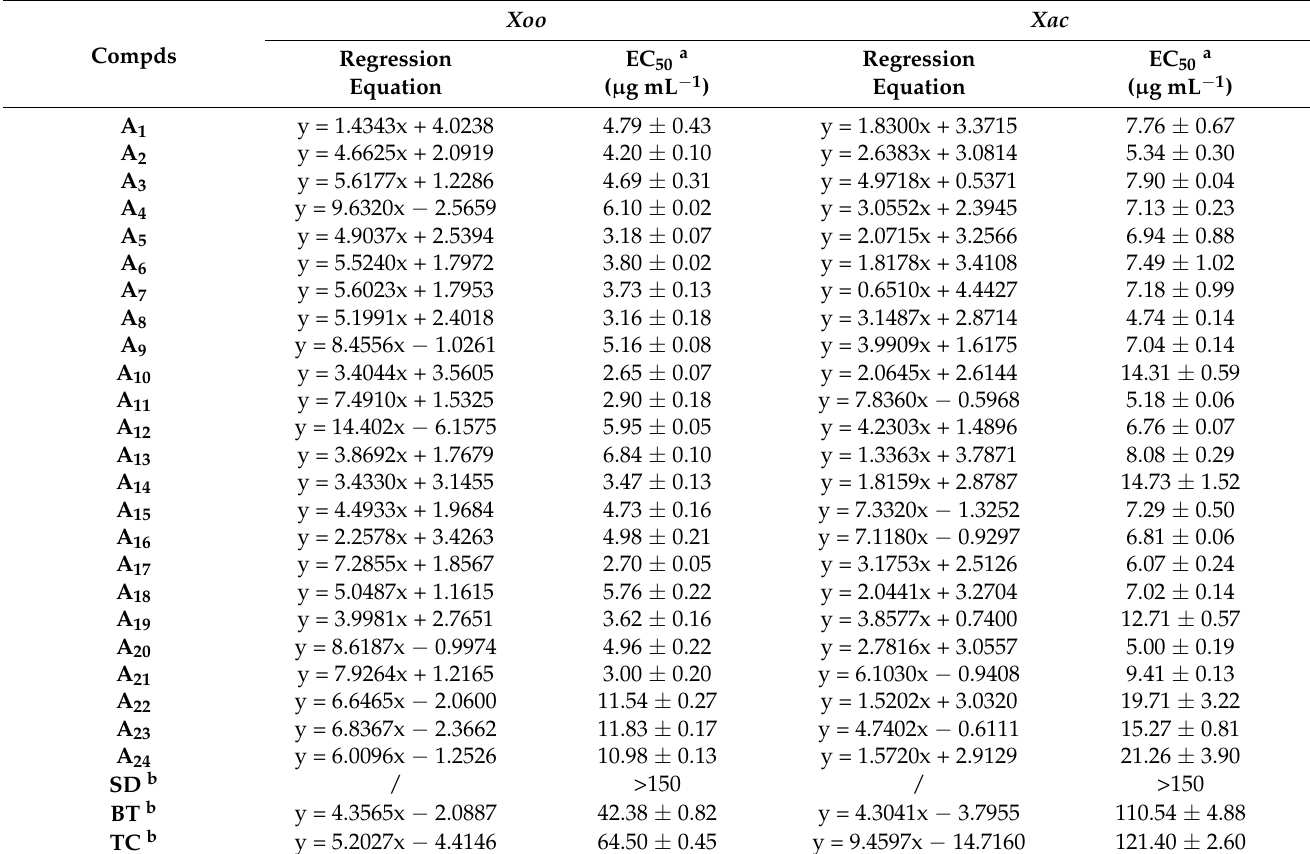
Table 1. In vitro antibacterial activities of target compounds A 1 − A 24 against plant